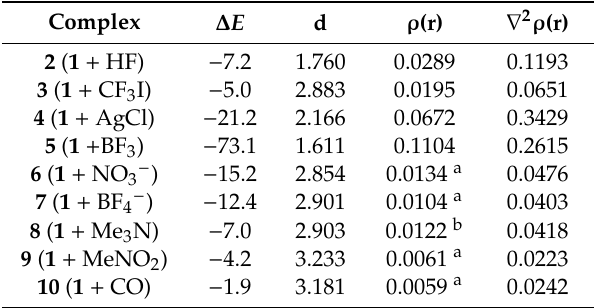
Table 2. Interaction distances and energies (d, in Å; Δ E in kcal mol − 1 ) at the PBE0-D3/def2-TZVP level of theory for complexes 2 – 10 . Values of electron charge density ρ (r) and its Laplacian at the bond critical points are given in a.u.